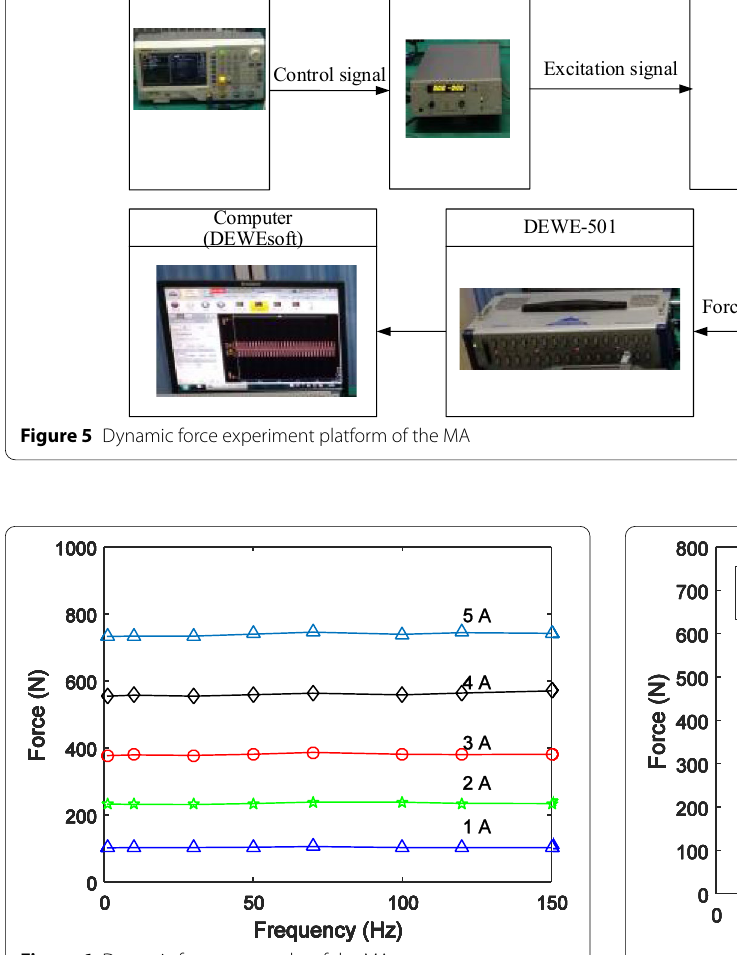
Figure 7 Output force-current relationship of the